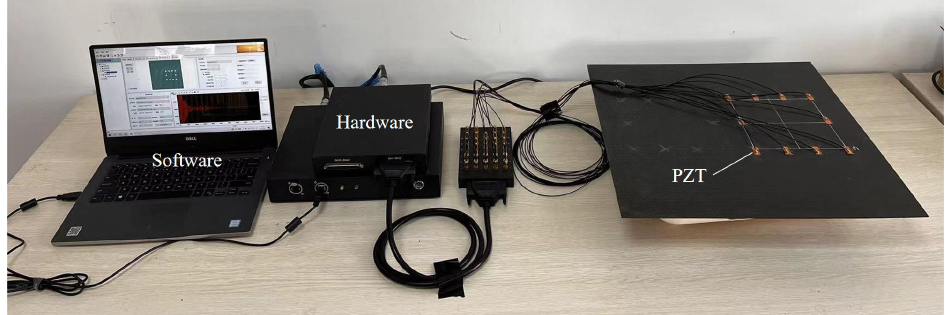
Figure 6. Experimental setup and testbed.